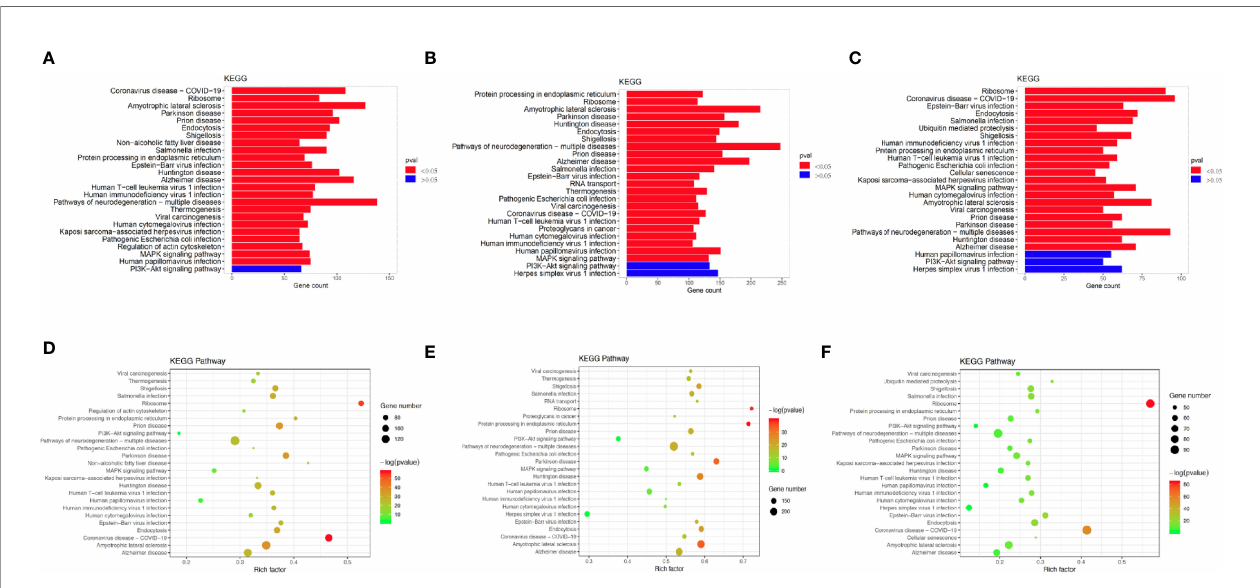
FIGURE 8 | Differences in pathway activities scored using Kyoto Encyclopedia of Genes and Genomes (KEGG) database between chemoresistant and chemosensitive samples. Top 25 differentially expressed genes (DEGs) enriched KEGG functional annotation on (A) epithelial, (B) T, and (C) B cells. The x -axis indicates the number of genes annotated to pathway and proportion of all DGEs, and the y -axis shows KEGG metabolic pathway. Red bar ( p < 0.05). Scatter plot of the top 25 DEGs enriched in the KEGG pathway on (D) epithelial, (E) T, and (F) B cells. Each circle indicates a KEGG pathway. Ordinate is log10 ( Q value), color- coded from green to orange to red. Circle sizes indicate enrichment level of DEGs in pathway. Q value: p -value after multiple hypothesis